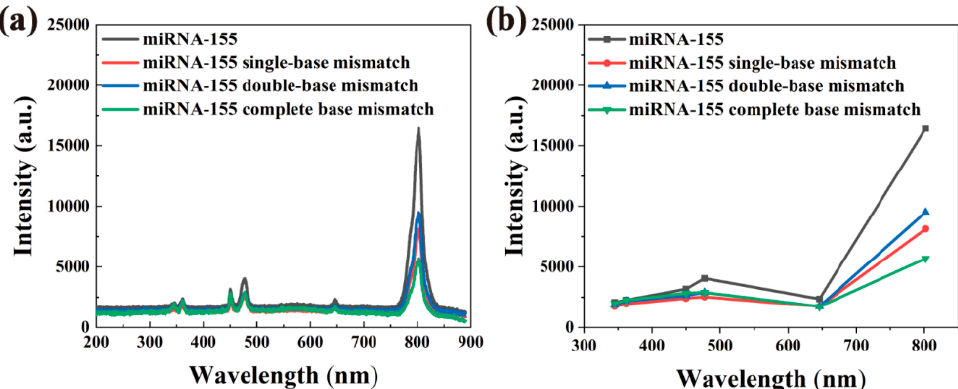
Figure 10. Fluorescence spectra of fluorescent probes connected to miRNA-155, miRNA-155 single-base mismatch, miRNA-155 double-base mismatch, and miRNA-155 complete-base mismatch. ( a ) Fluorescence spectra of mismatched sequences relative to miRNA-155 at 980 nm excitation. ( b ) MiRNA-155 with different sequences, the relationship between the maximum intensity of the luminescence peak corresponding to sequences change.